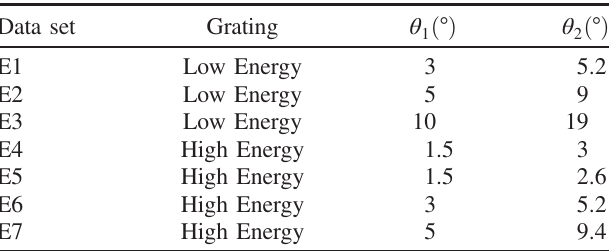
TABLE IV. Table of energy scan data sets, for aluminum sample #1. The out-of-plane angle is fixed at ϕ ¼ 0 .